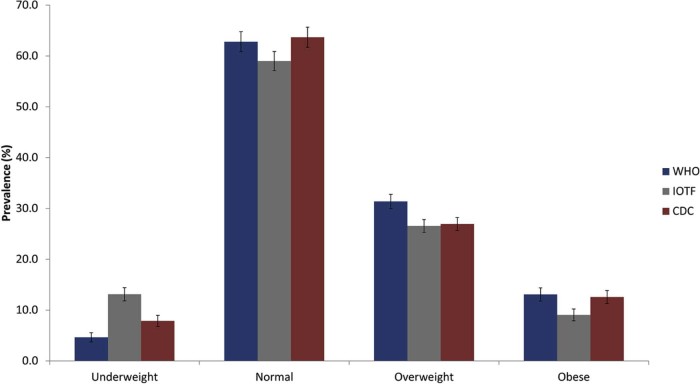
Overall prevalence of underweight, normal weight, overweight and obesity among children in Segamat, Malaysia according to 3 international references: CDC reference, IOTF reference, and WHO reference.